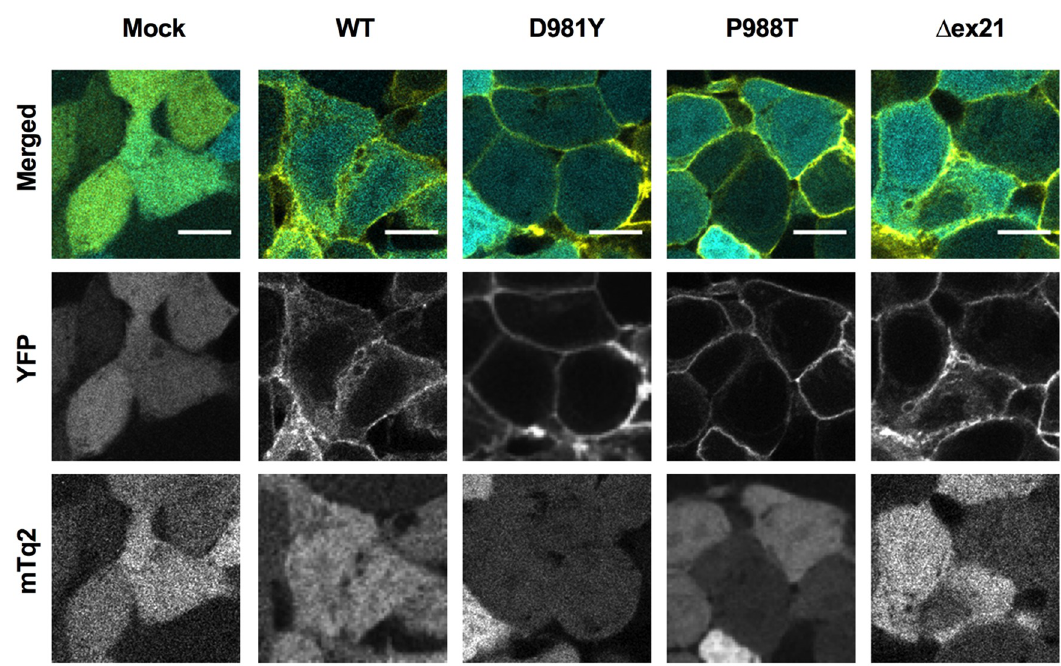
Fig 5. Plasma membrane localization of the recSLC12A2 constructs in HEK293T cells. Top , Cellular localization of the recSLC12A2 constructs was assessed by observing the fluorescence of YFP (yellow) attached to the amino-terminus of each SLC12A2 construct. The signals were merged with those of cytosolic mTq2 (cyan) co-expressed with each construct to identify the cell boundaries. Middle and bottom , images of YFP ( middle ) and mTq2 ( bottom ) channels are shown in gray. Scale bars, 10 μ m.